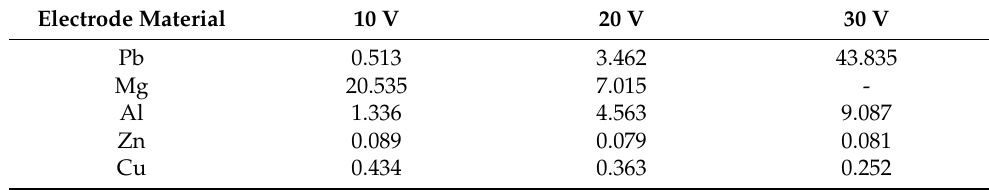
Table 5. Metallic concentrations in the effluent after microalgae recovery (mg/L). Electrode